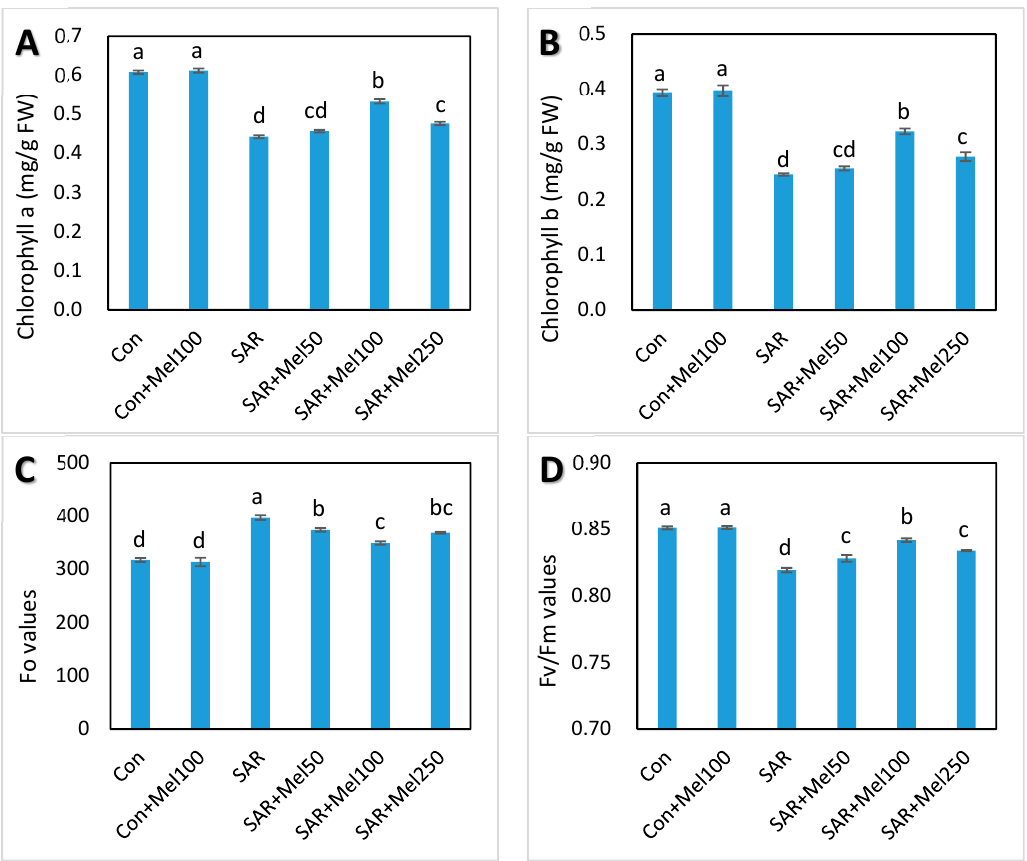
Figure 4. Changes of photosynthesis activities in tomato leaves by SAR and/or melatonin treatments. ( A ) chlorophyll a; ( B ) chlorophyll b; ( C ) Fo values; ( D ) Fv/Fm values. Data indicates here the mean of four replications. Vertical bars indicate the standard error. Means not sharing a common letter within the graph are significantly different at p ≤ 0.05 according to Tukey’s test.